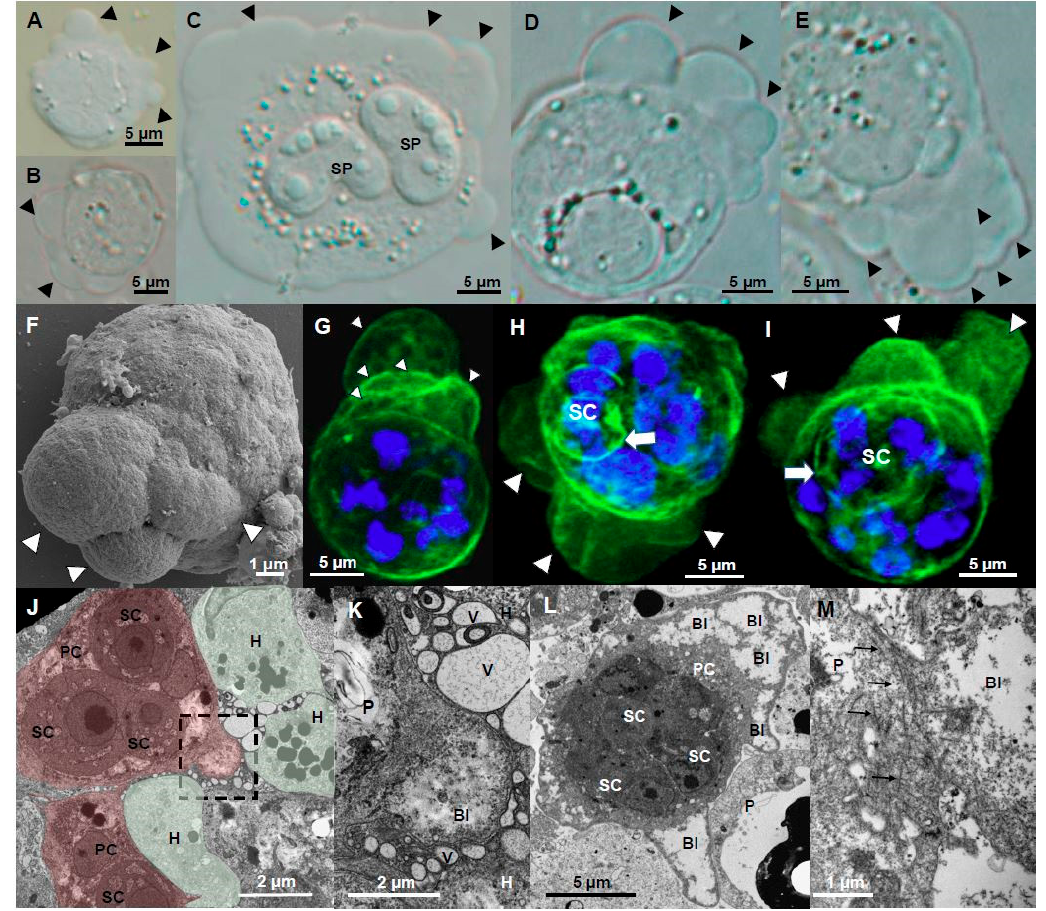
Figure 1. Bleb protrusions on Ceratonova shasta genotype IIR stages in rainbow trout. ( A , B ) Small presporogonic stages showing active blebbing. ( C – E ) Sporogonic stages showing active polarized blebbing, in ( C ) stage contains two myxospores. ( D , E ) Overlapping blebs, concentrated at one side of the stage. ( F ) External appearance of 3 overlapping blebs. ( G – I ) F-actin distribution on blebbing